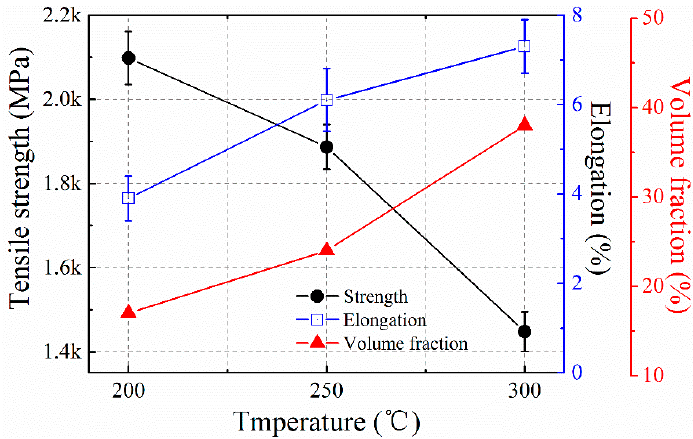
Figure 12. Mechanical properties of the laser cladded bainitic coatings.